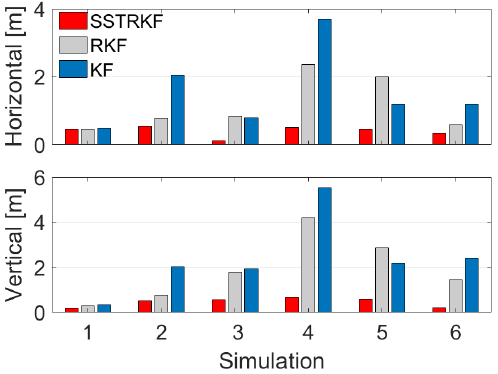
Figure 10. RMS positioning errors of the three schemes during the six